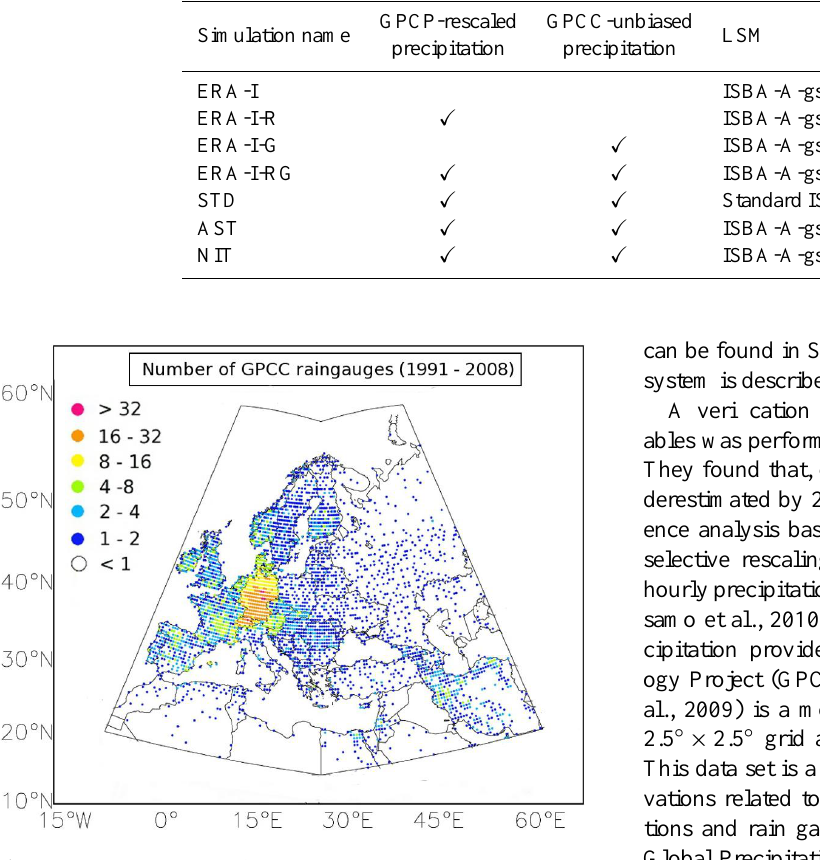
Fig. 1. Mean number of GPCC rain gauges per grid cell (0.5 ◦ × 0.5 ◦ ) used to rescale the ERA-I precipitation data set over the 1991–2008